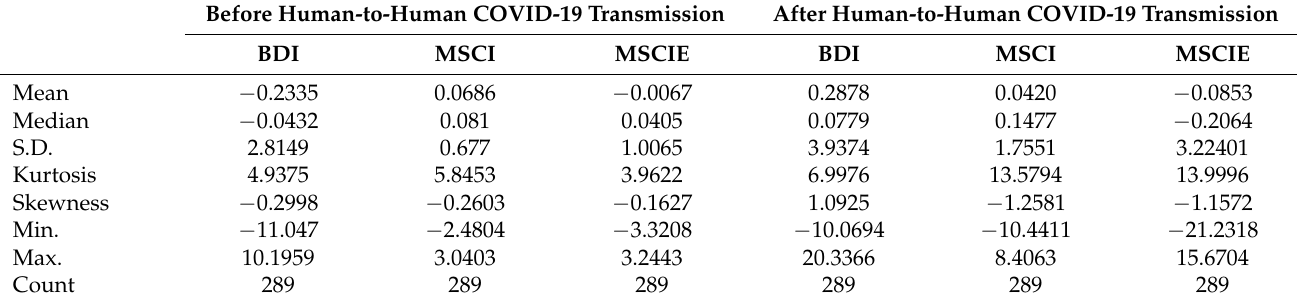
Table 1. Summary statistics: the returns of the daily prices of BDI, MSCI, and MSCIE. Before Human-to-Human COVID-19 Transmission